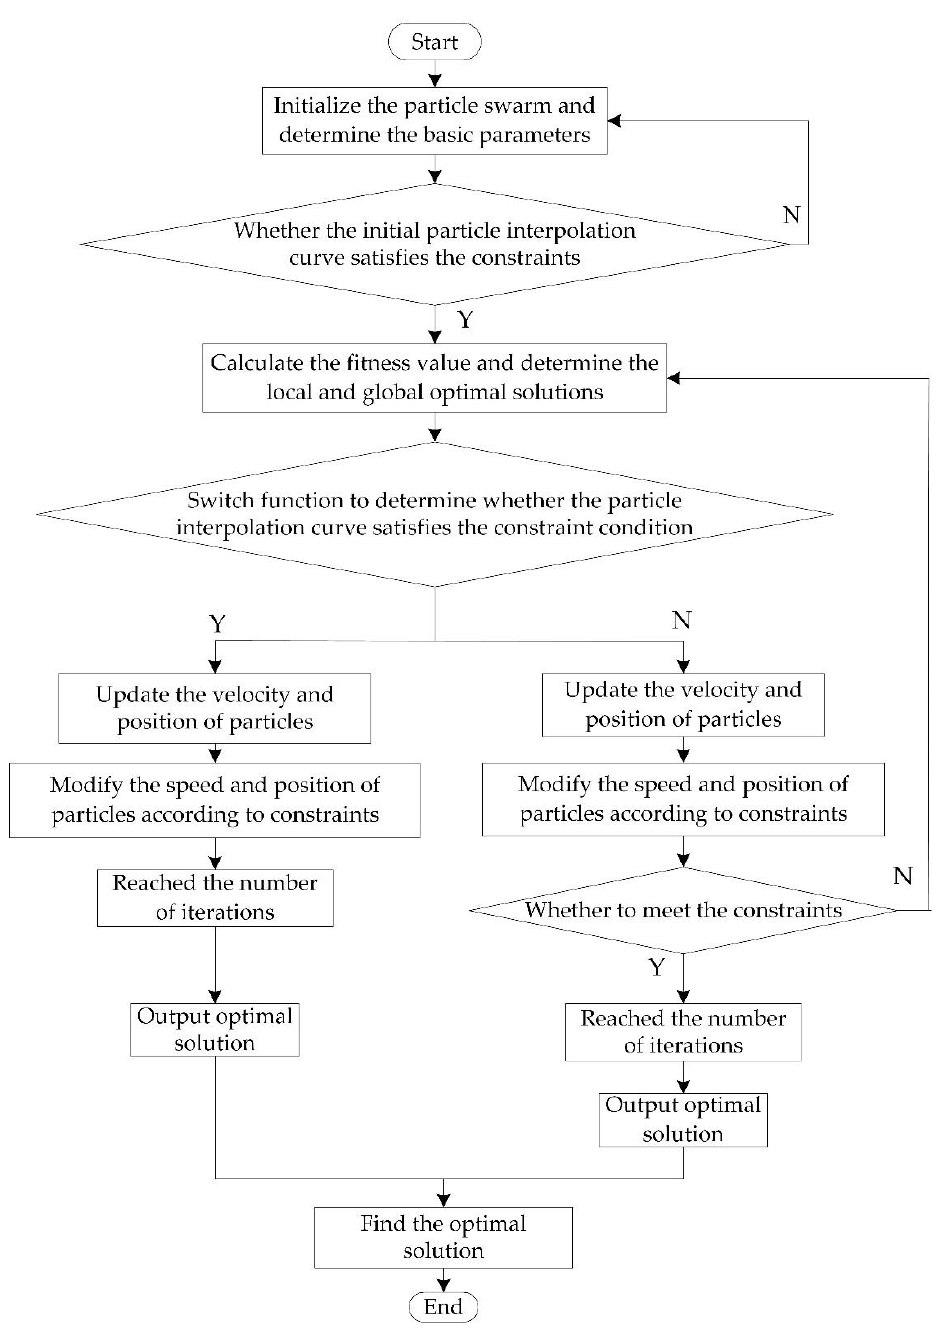
Figure 9. Improve PSO